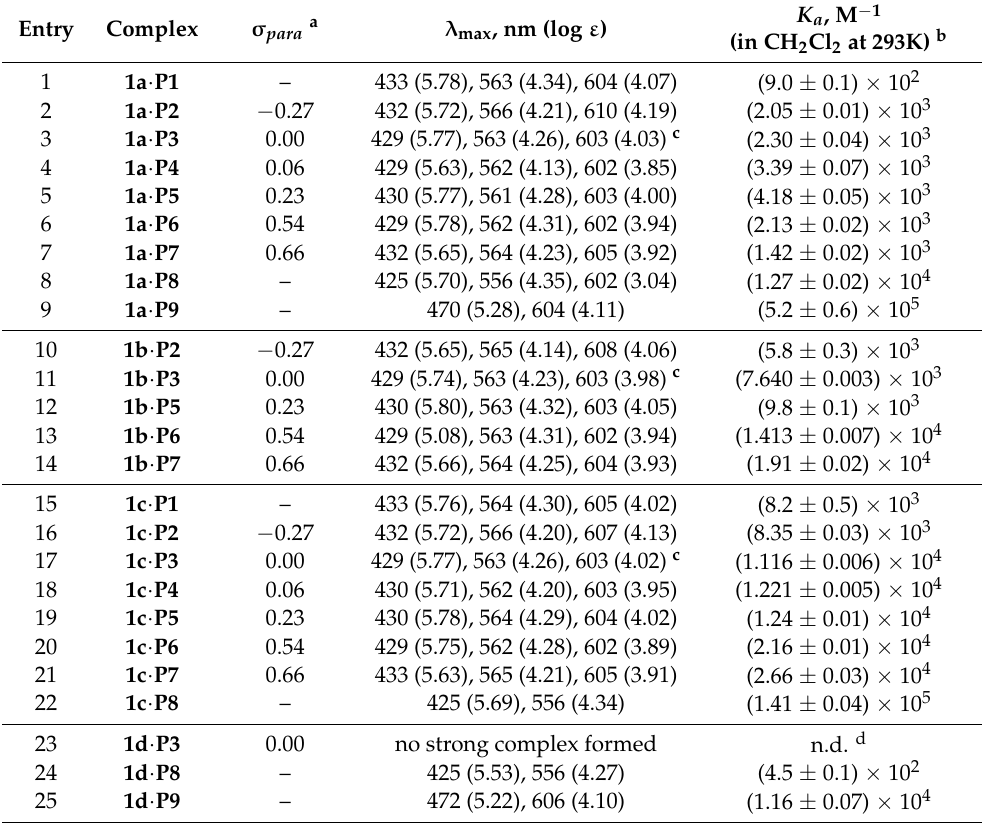
Table 2. Association constants ( K a ), Hammett substituent constants ( σ para ) for para substituted benzene rings in porphyrins P2 – P7 , and absorption maxima ( λ max ) in UV-Vis spectra for complexes of thioureas 1a – d with zinc porphyrins P1 – P9 measured in CH 2 Cl 2